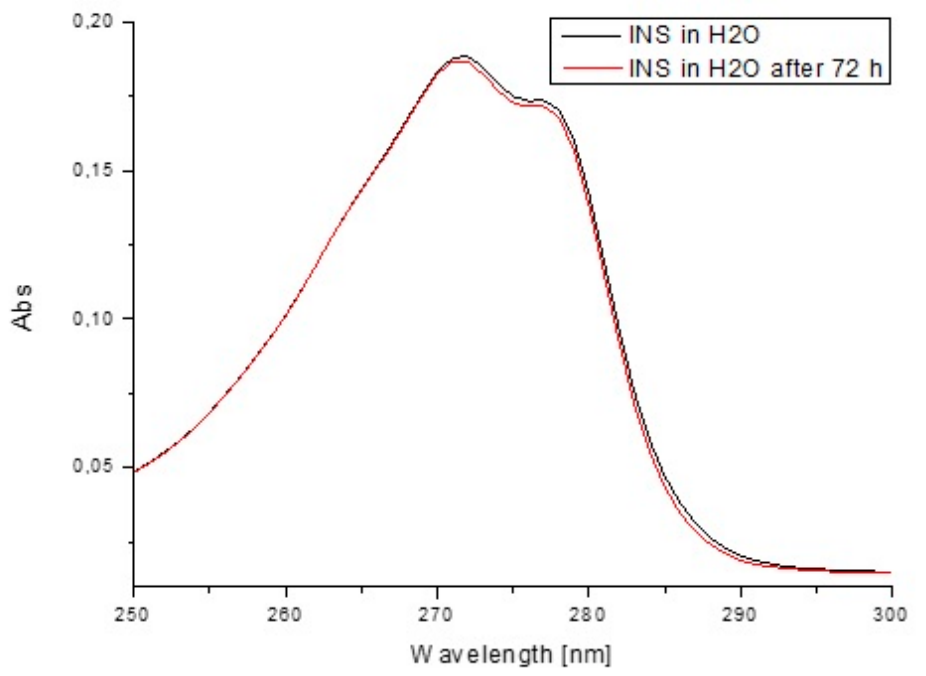
Figure 15. Absorption spectra of insulin at 1.04 × 10 − 5 g/cm 3 concentration both in H 2 O immediately after sample preparation and after 72 h.